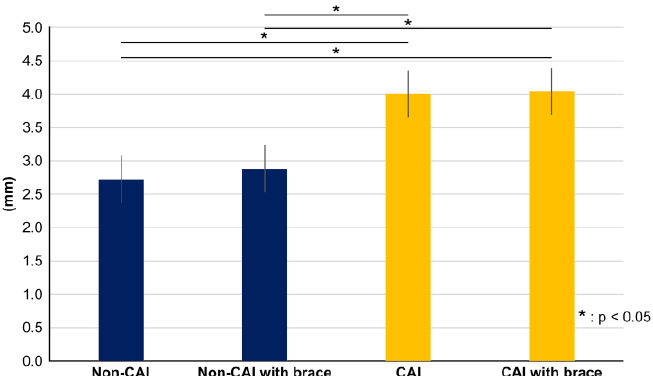
Figure 6. Graph showing the amount of change in medial–lateral direction of the center of pressure. The horizontal axis indicates each condition, and the vertical axis indicates the amount of change. There was a signi fi cant di ff erence between the CAI and non-CAI sides, but there was no signi fi cant di ff erence between with or without the brace.